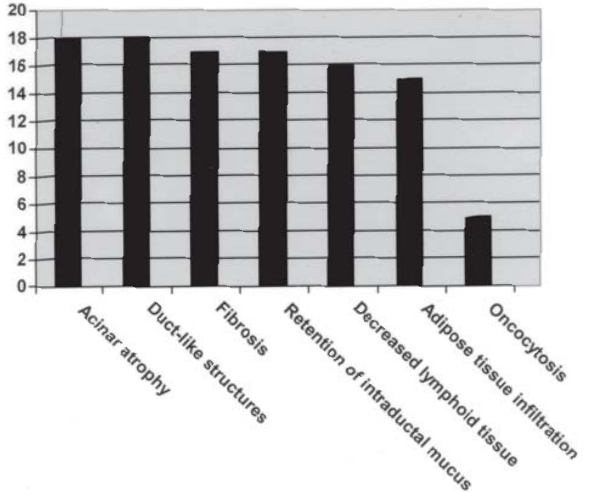
FIGURE 3 - Number of microscopic alterations in the affected